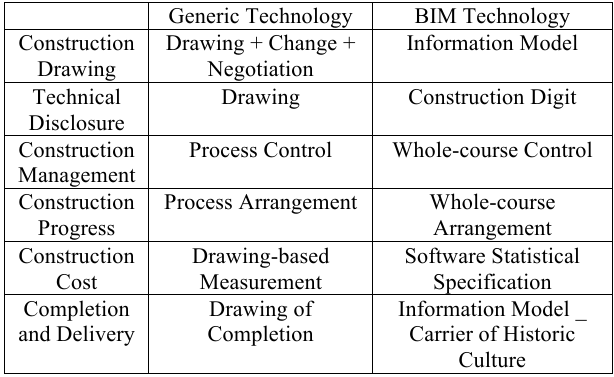
Table 1. Generic Technology vs. BIM